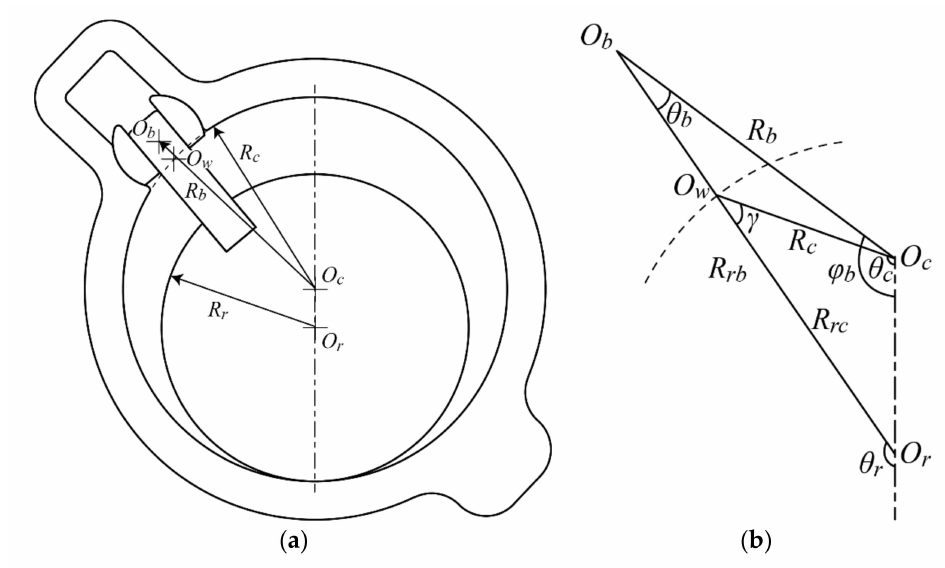
Figure 2. Type-I RV geometric relations; ( a ) Type-I RV layout; ( b ) Type-I RV